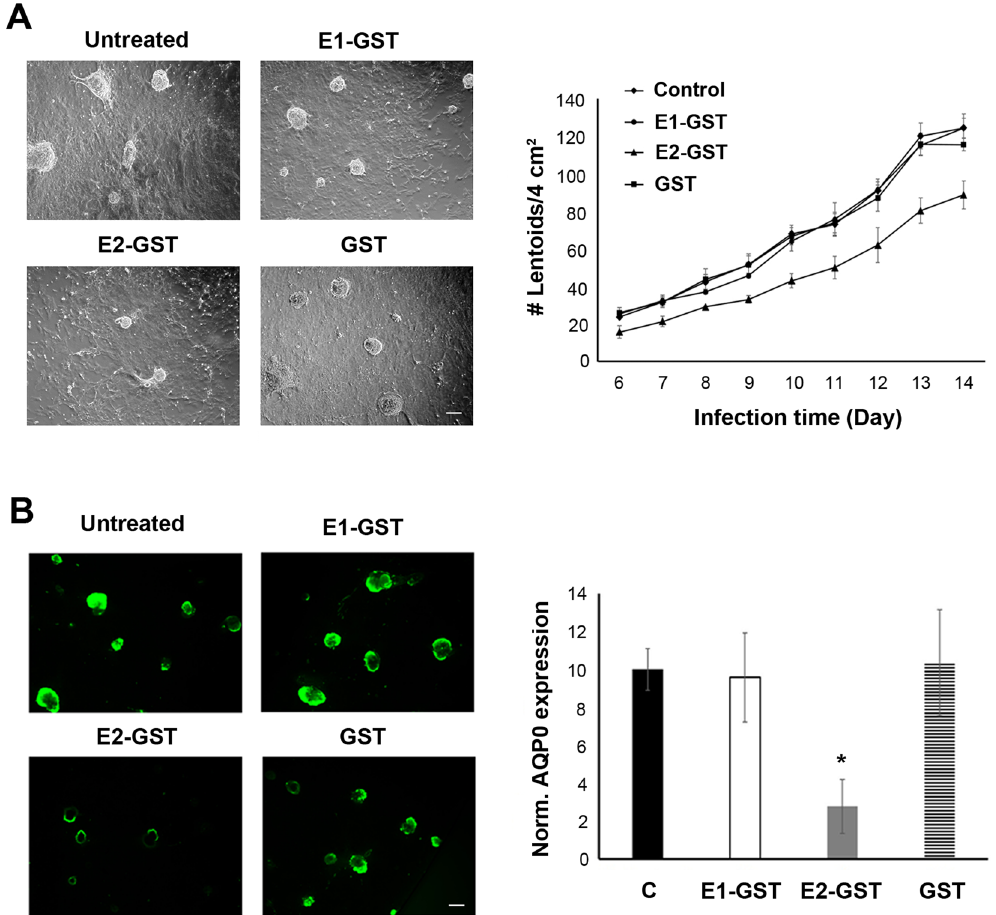
Figure 5. Disruption of cell adhesion by Cx50 E2 domain impairs lens epithelial-fiber cell differentiation. ( A ) Cx50 E1-GST, E2-GST or GST was used to treat primary lens cell culture every day starting at the 2nd day of cell seeding. Representative images of primary culture cells treated with GST-E1, E2 fusion proteins or GST protein and untreated control were taken on the 10 th day of primary culturing. Starting at the 6th day of the treatment, the total lentoid numbers were quantified each day until day 14. ( B ) Fourteen days after injection, fixed primary lens cells were immunostained with anti-AQP0 antibody and detected by fluorescein-conjugated anti-rabbit IgG. The signals of AQP0 expression areas versus whole-image areas were quantified. The data are presented as the mean ± SEM. * P < 0.05; ** P < 0.01; *** P < 0.001. n = 3. Bar, 200 µ